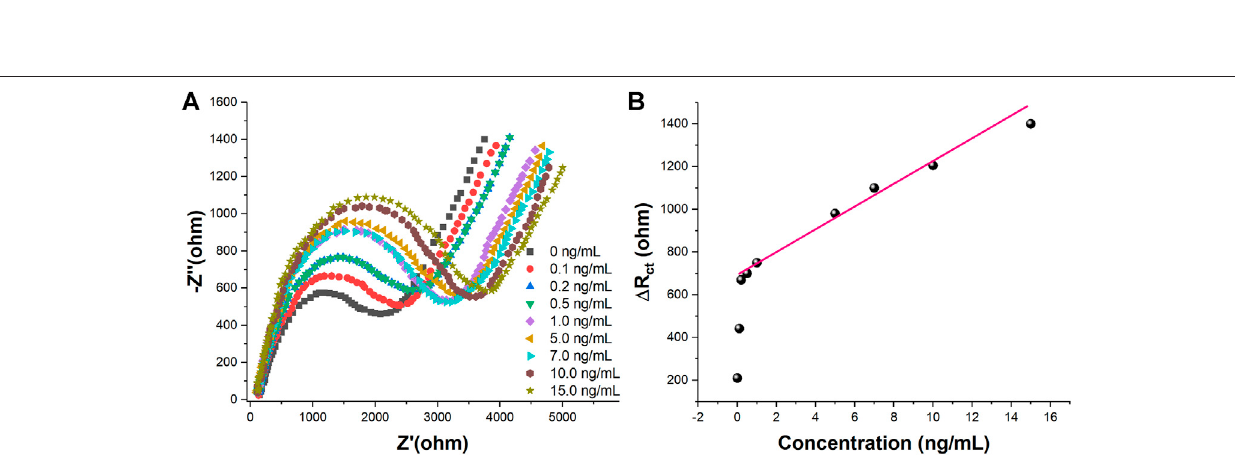
FIGURE 6 | The effect of (A) CEA-A concentration (B) immobilization time and (C) incubation time on the aptasensor performance ( n (cid:2) 3).